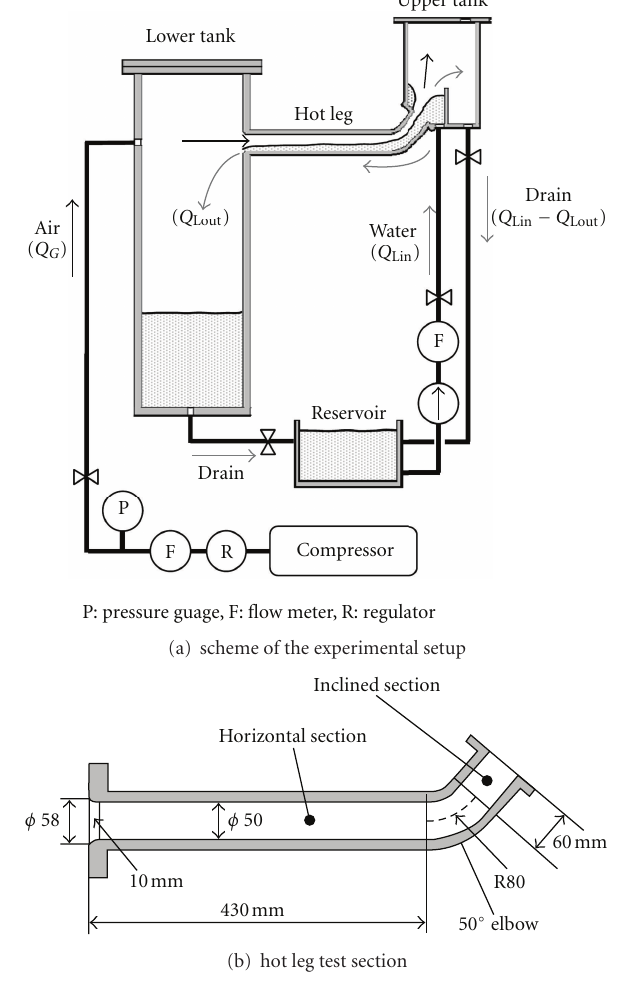
Figure 1: Hot leg test facility of Kobe University.